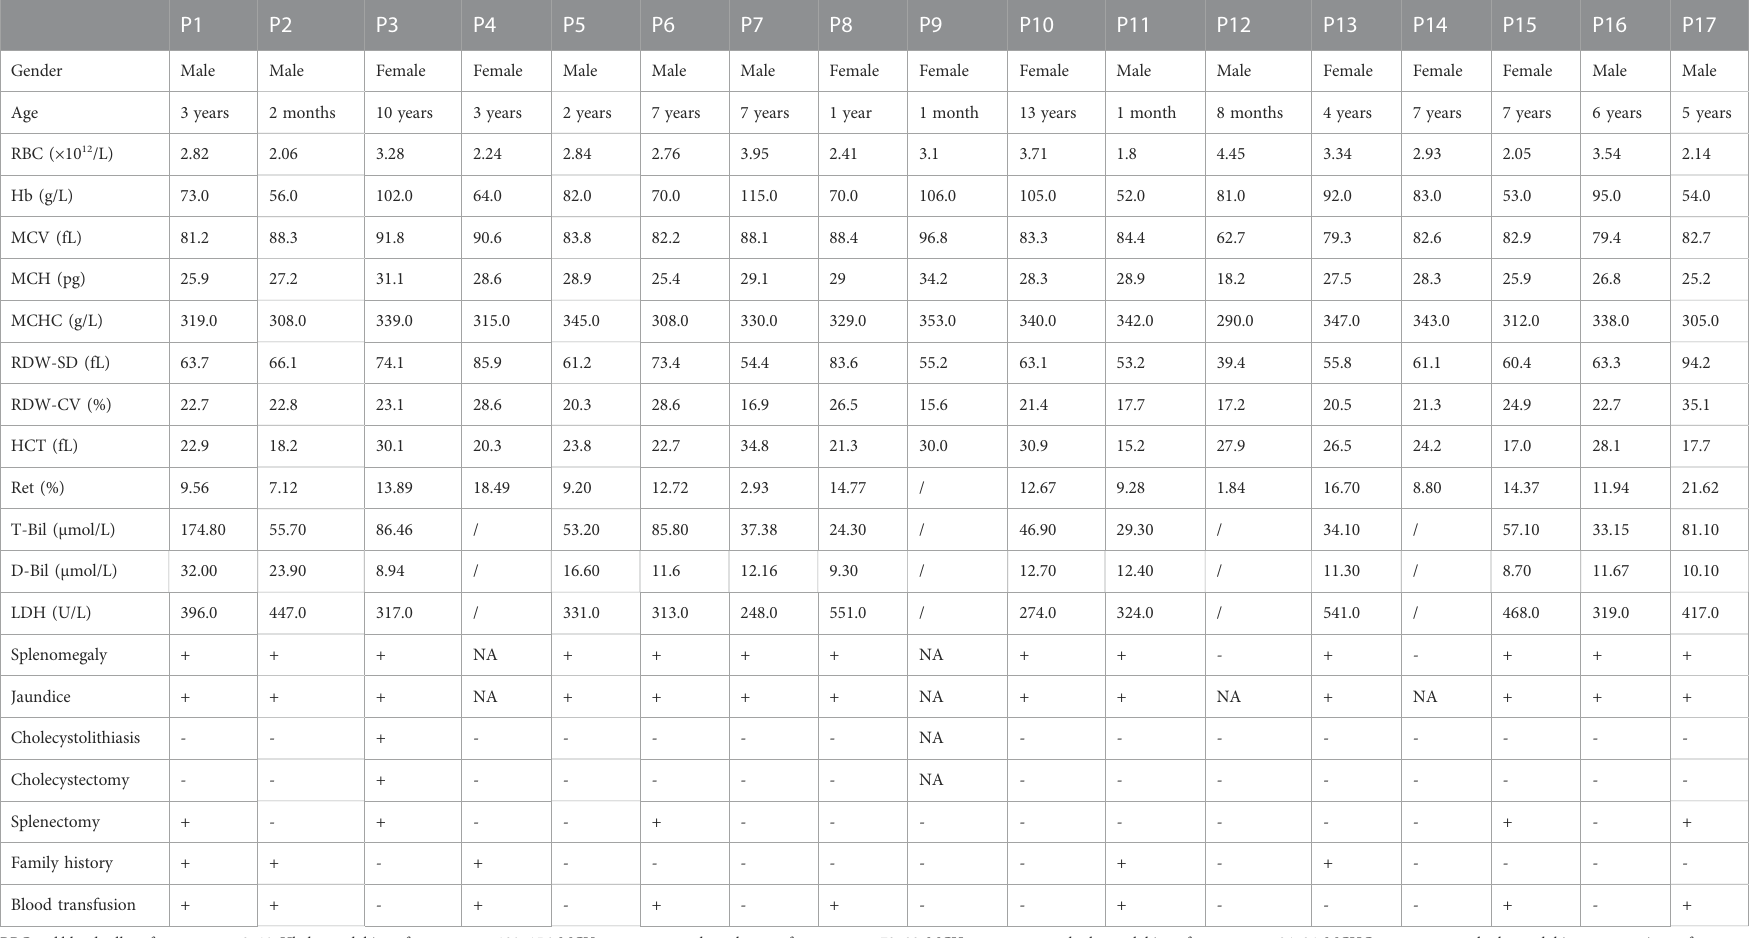
TABLE 2 Laboratory testing results of 17 patients with hereditary spherocytosis caused by ANK1 mutations. P1 P2 P3 P4 Gender Male Male Female Female Male Male Male Female Female Female Male Male Female Female Female Male Male Age 3 years RBC (×10 12 /L) Hb (g/L)